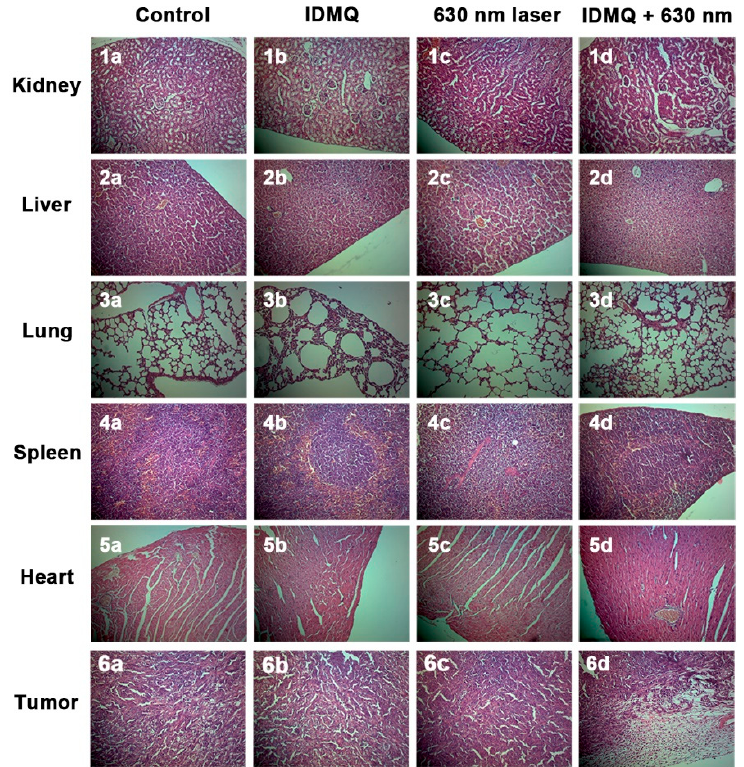
Figure 12. Images of H&E staining of the main organs in the control, 630 nm laser irradiation, QICY, and QICY + 630 nm groups on day 16 after treatment.